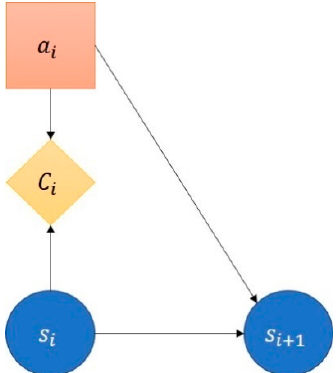
Figure 6. Graphical representation of a Markov Decision Process. The combination of an action a i and a state s i results in a new state s i + 1 and a cost C i . The objective is to find an optimum policy π ∗ that minimizes the accumulated cost when taking successive actions from an initial state. The transition from s i to s i + 1 is probabilistic, such that one has to account for the uncertainties associated to the system’s evolution.